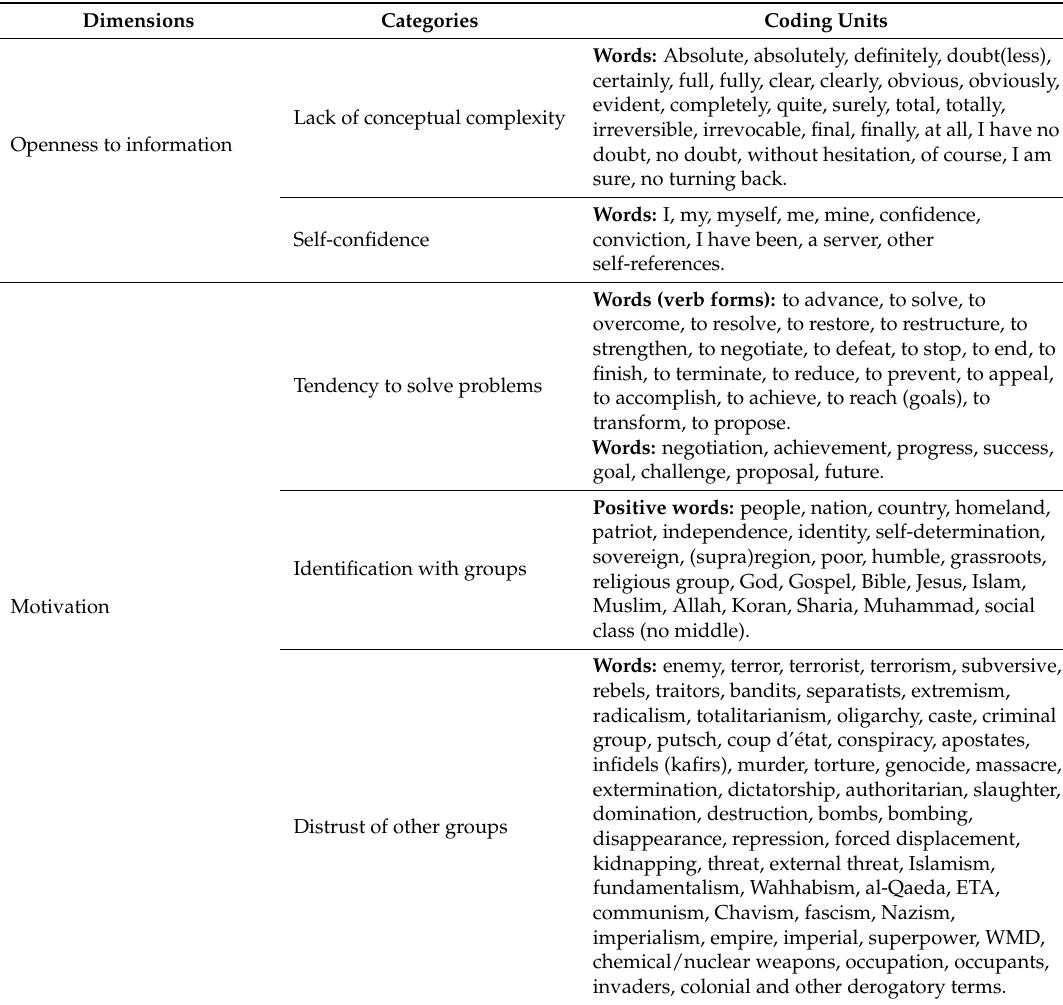
Table 2. Content analysis: dimensions, categories and coding